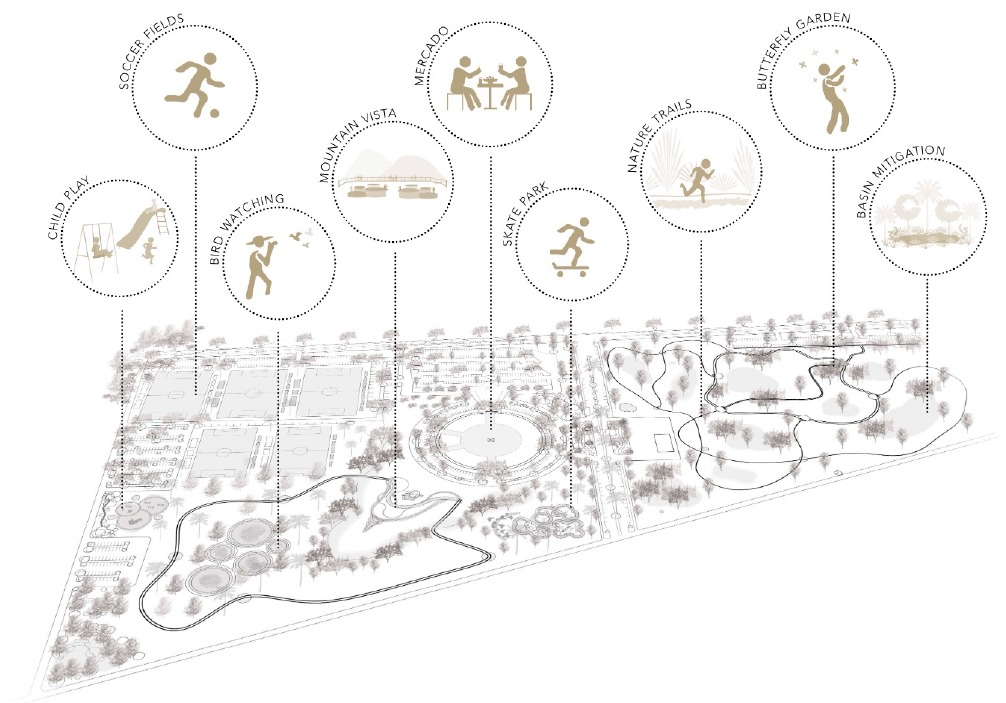
Figure 8. Focused design areas of the master plan for the stormwater park in Hermosillo, Mexico (credit: I. Pineda).